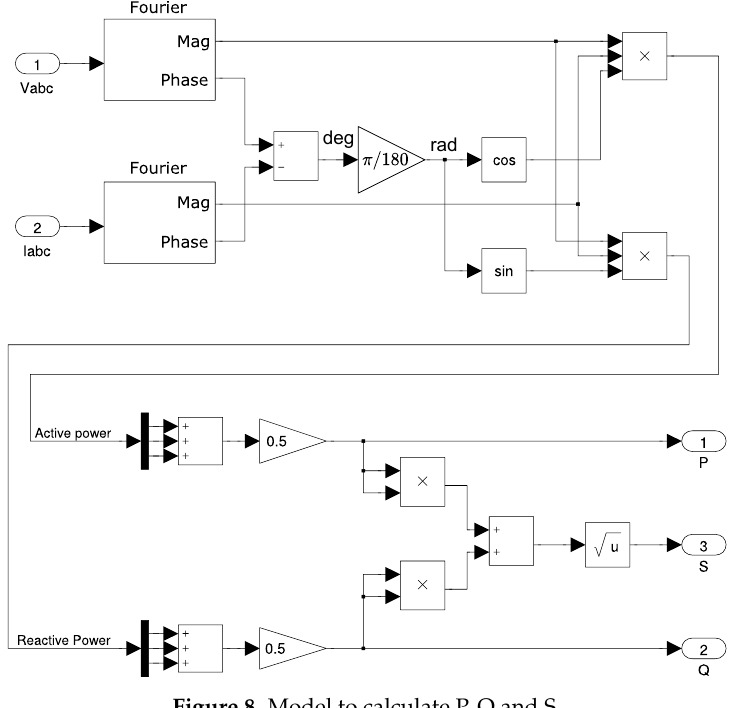
Figure 8. Model to calculate P, Q and